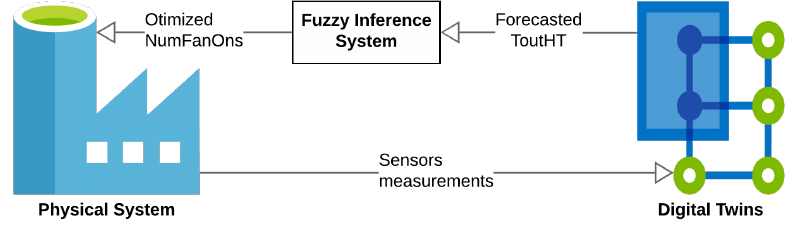
Figure 12. Application of digital twins to determine number of